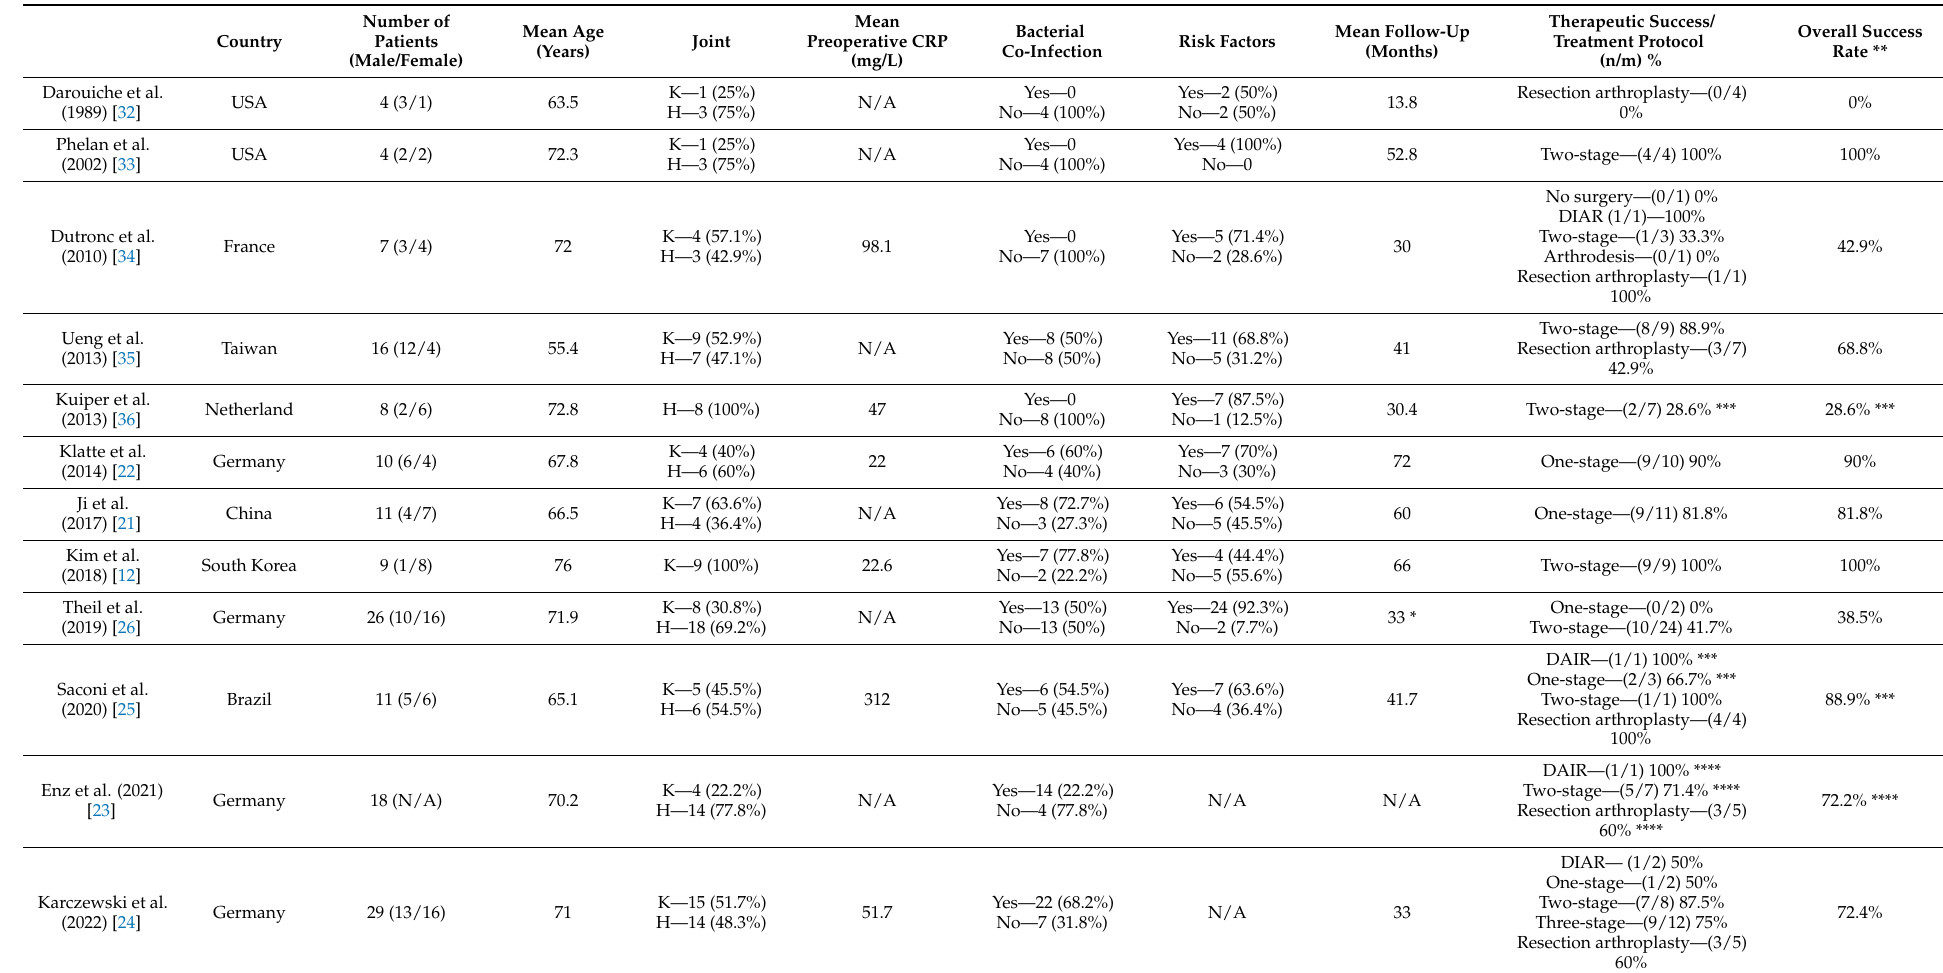
Table 2. General overview of the analyzed